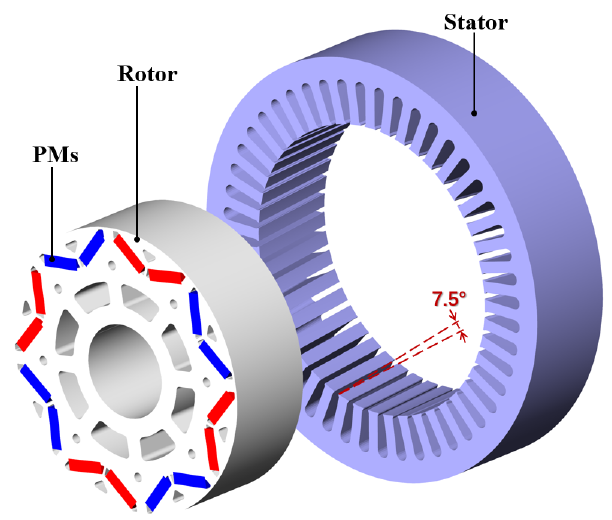
Figure 1. Motor structure diagram of skewed slot motor.